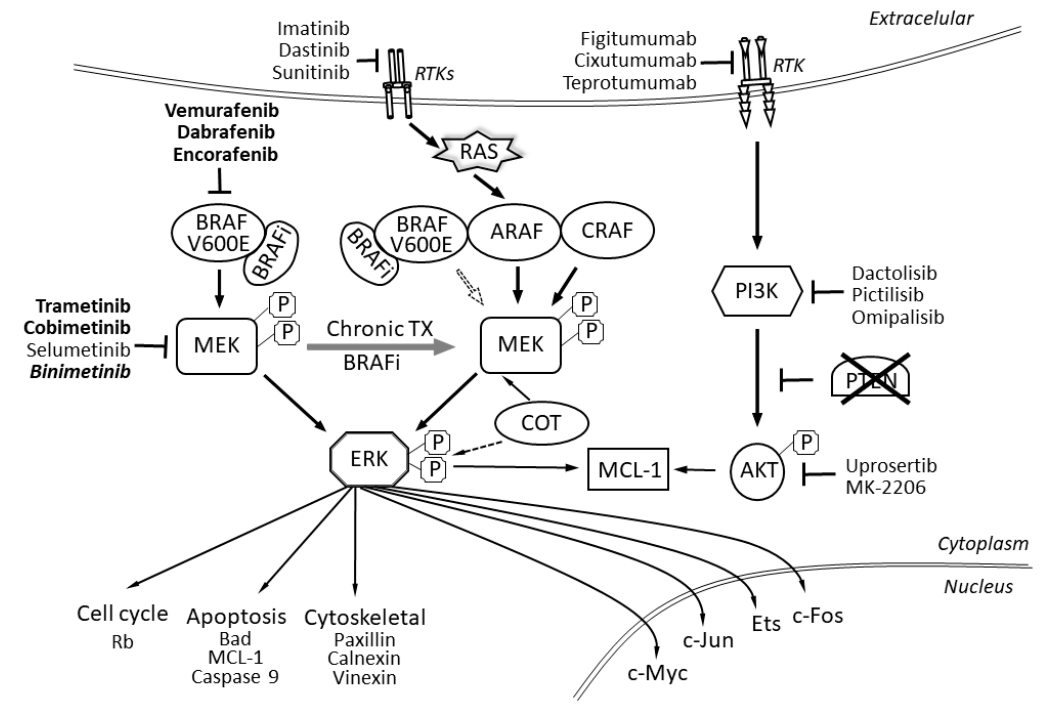
Figure 1. BRAF signaling pathway including abnormal signaling from BRAFV600E mutated proteins.